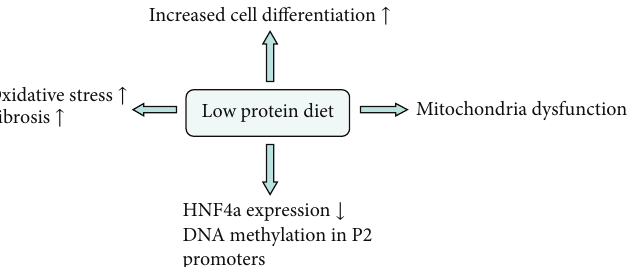
Figure 2: The effect of low protein diet during pregnancy on postnatal 𝛽 cell. Low protein diet during pregnancy may lead to increased oxidative stress, fibrosis, decreased HNF4a expression, defected mitochondriogenesis, and mitochondria dysfunction, and increased cell differentiation instead of proliferation was found in 𝛽 cell of adult animal offspring, which may participate in 𝛽 -cell dysfunction and consequently increase the incidence of